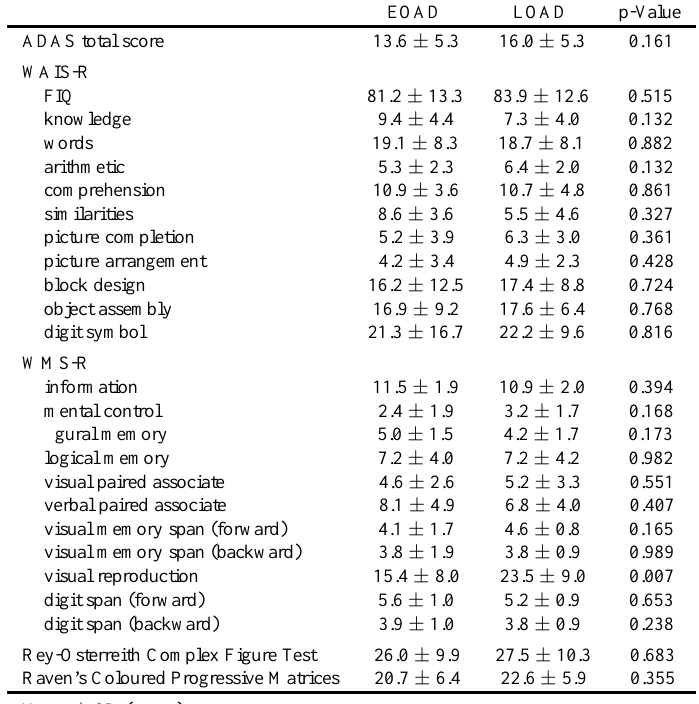
Table 2 Neuropsychological test scores in patients with Alzheimer’s